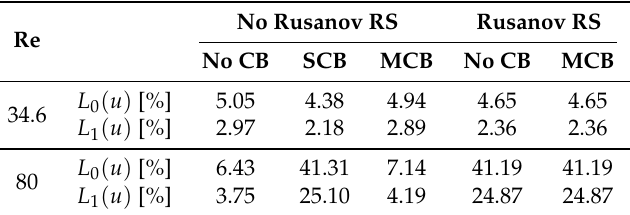
Table 3. L 0 and L 1 error norm of the velocity profiles for the AC method using different combinations of CB schemes and the Rusanov Riemann solver at Re = 34.6 and Re = 80.